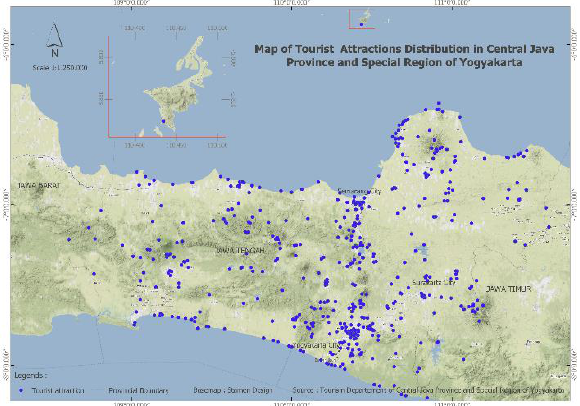
Figure 4.1 Map of tourist distribution using big data instagram